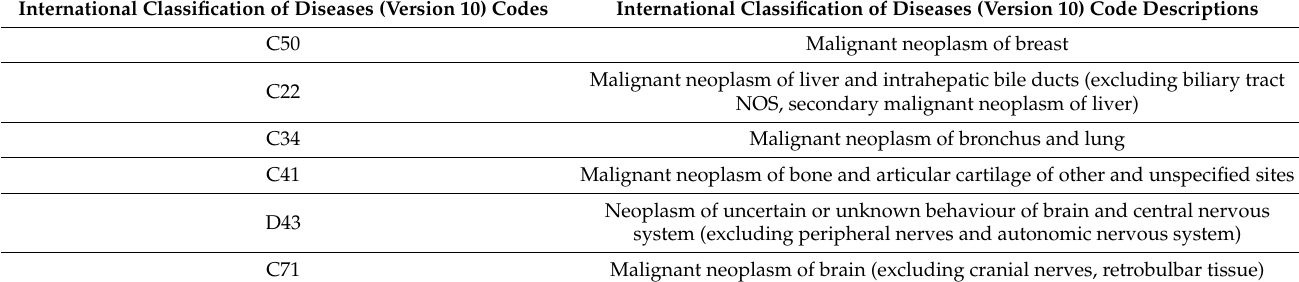
Table A3. International Classification of Diseases version 10 diagnosis codes associated with proce- dures that indicated a second breast cancer